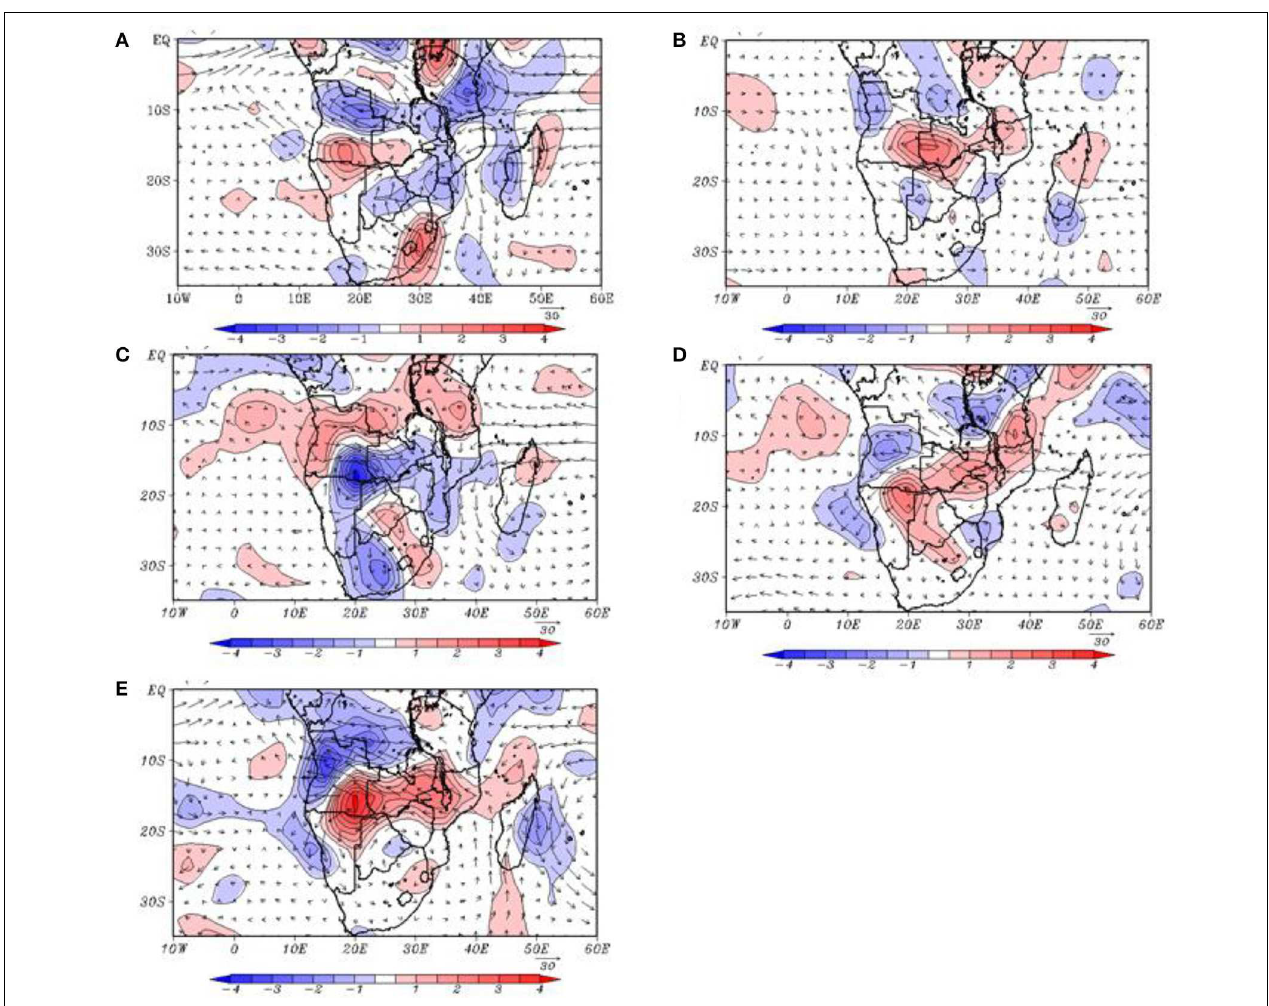
FIGURE 6 | FMA anomalies in moisture fluxes and divergence (contour interval 0. 5 × 10 − 8 gkg − 1 s − 1 ) at the 850 hPa level for (A) 1963, (B) 1986, (C) 2001, (D) 2006, and (E) 2011. Areas of relative convergence are shaded and a scale vector in gkg − 1 ms − 1 is